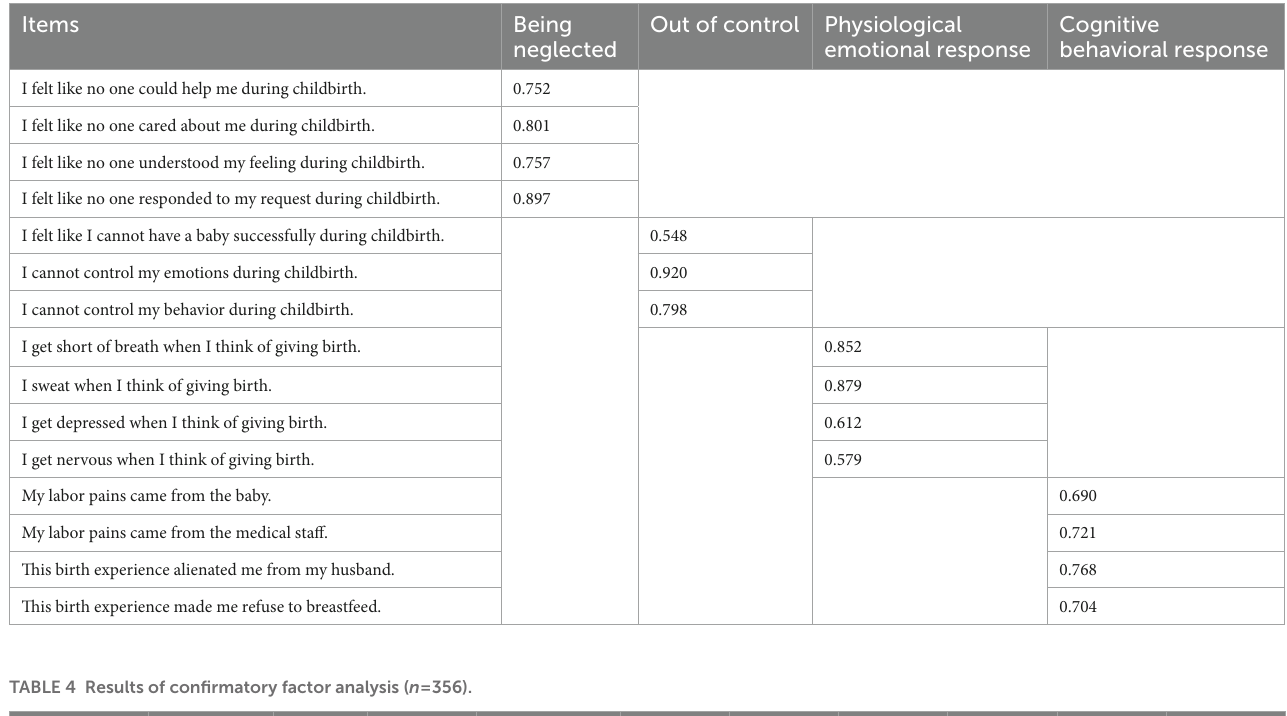
TABLE 3 Factor loading of each item of BTS.